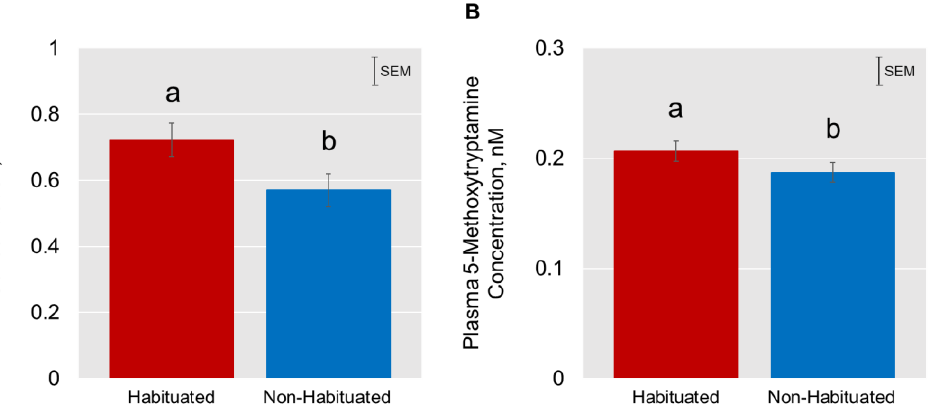
Figure 4. Effects of habituation treatment on plasma ( A ) phenylethylamine and ( B ) 5-methyltryptamine concentrations in goats. ab Bars with different letters differ significantly ( p < 0.05) by LSD test.